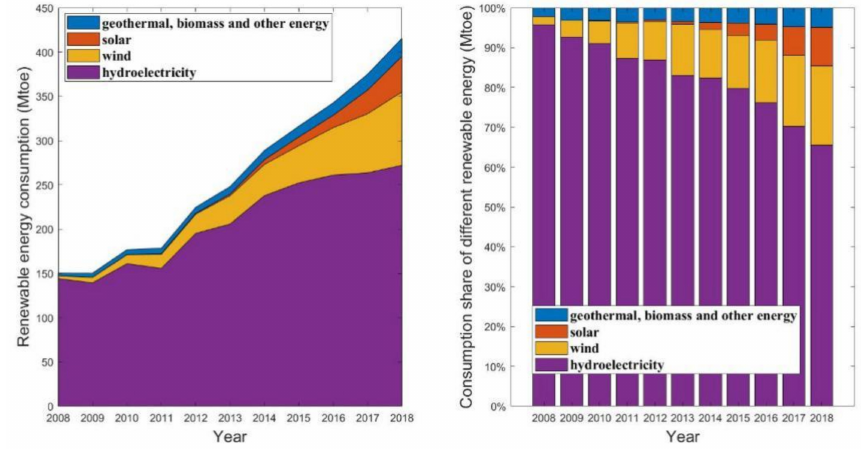
Figure 1. The composition of renewable energy consumption in